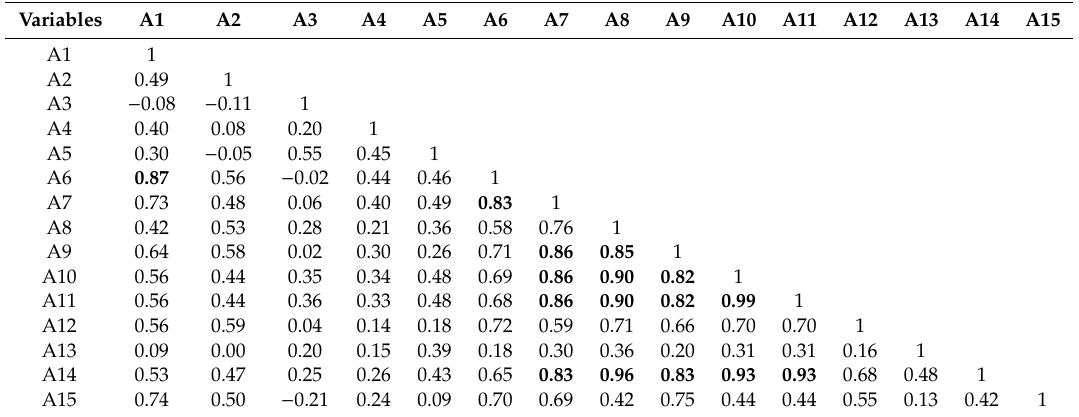
Table 2. Correlation